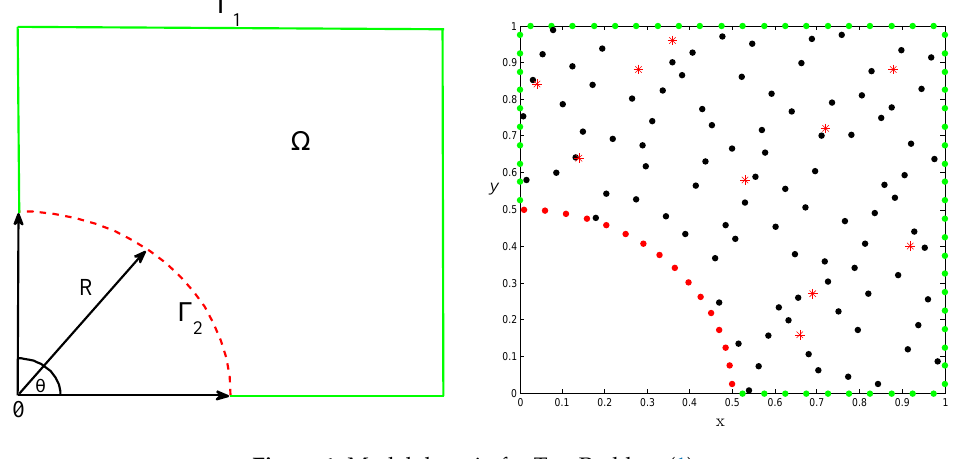
Figure 1. Model domain for Test Problem